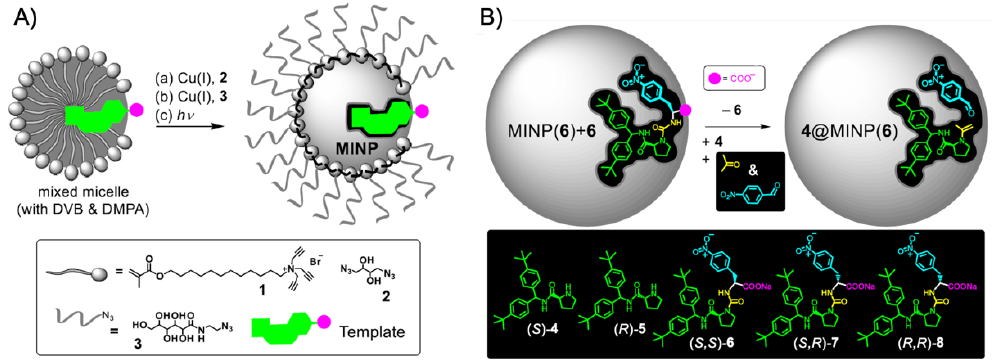
Figure 15. Chiral gating of substrates for asymmetric aldol reactions. ( A ) Templated polymerization of a cross-linked micelle. ( B ) Molecularly imprinted nanoparticles prepared by peptide chemistry. Adapted with permission of [135]. Copyright 2015 American Chemical Society.